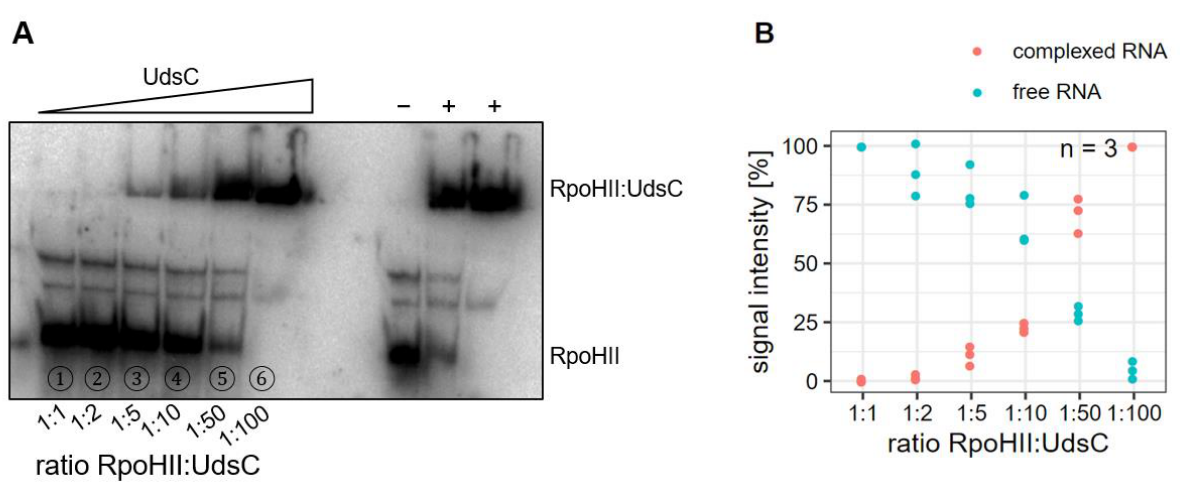
Figure 5. ( A ) Gel retardation assay of an RpoHII segment (93 nt) and UdsC (70 nt). 32 P-labelled RpoHII in vitro transcripts [150 fmol] were incubated together with increasing concentrations of unlabeled UdsC in vitro transcript. Samples were loaded onto a 6% non-denaturing polyacrylamide gel containing 0.5× TBE. ( B ) Quantification of the free and complexed RNA from three independent gel retardation assays by phosphoimaging.